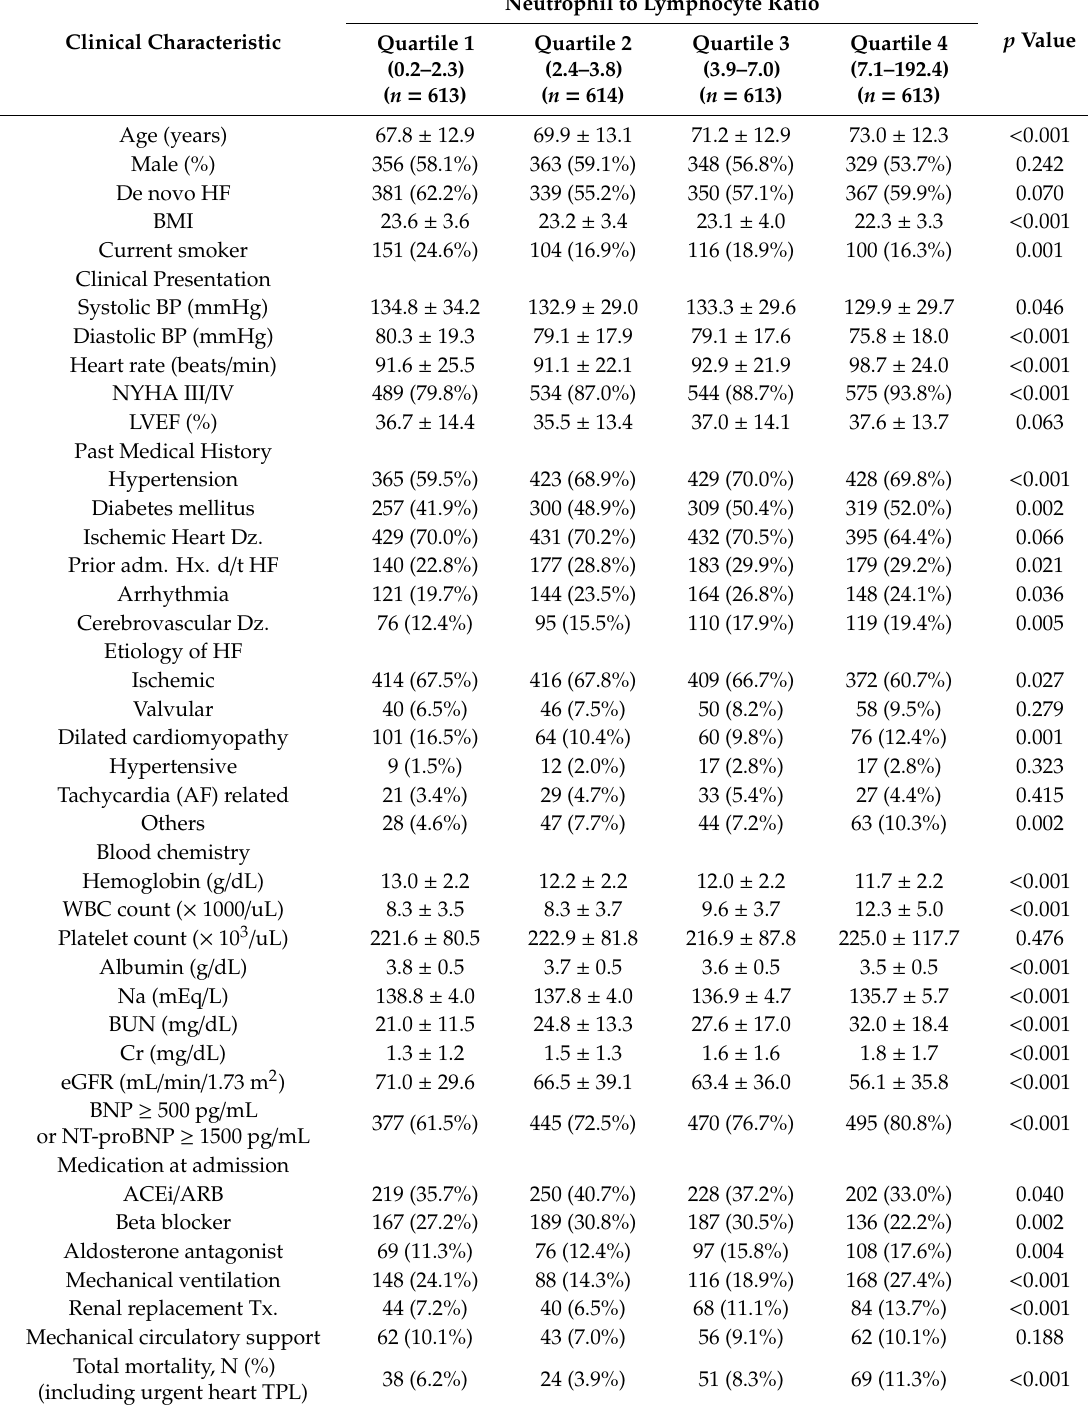
Table 5. Baseline clinical characteristics of HF patients whose aggravating factor were infection or ischemia stratified by quartiles of neutrophil to lymphocyte ratio at admission. HF, heart failure; BMI, body mass index; BP, blood pressure; NYHA, New York Heart Association; LVEF, left ventricular ejection fraction; HF, heart failure; AF, atrial fibrillation; WBC, white blood cells; BUN; blood urea nitrogen; Cr, creatinine; eGFR, estimated glomerular filtration rate; BNP, brain natriuretic peptide; NT-proBNP, n-terminal brain natriuretic peptide; ACEi, angiotensin-converting-enzyme inhibitor; ARB, angiotensin II receptor blocker; Tx., therapy; TPL,